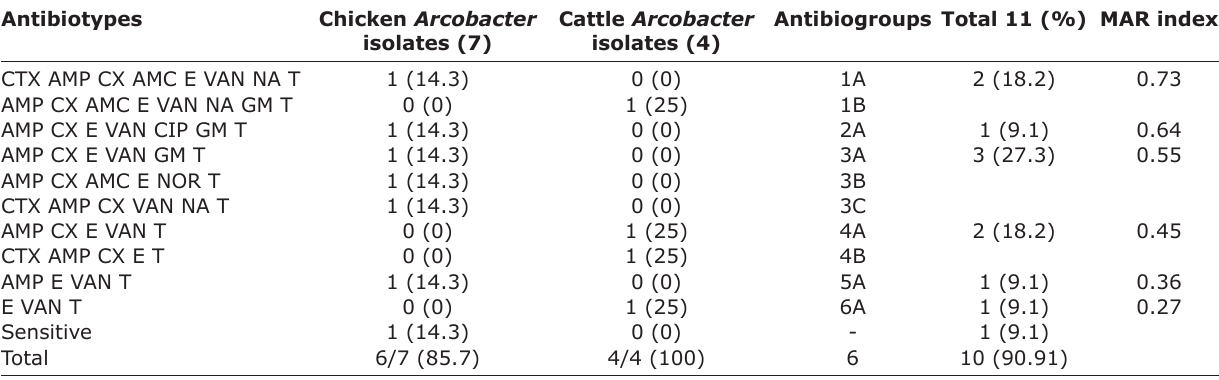
Table-4: Antibiogram and MAR index of Arcobacter spp. recovered from retail meat in Wasit marketplaces. Antibiotypes